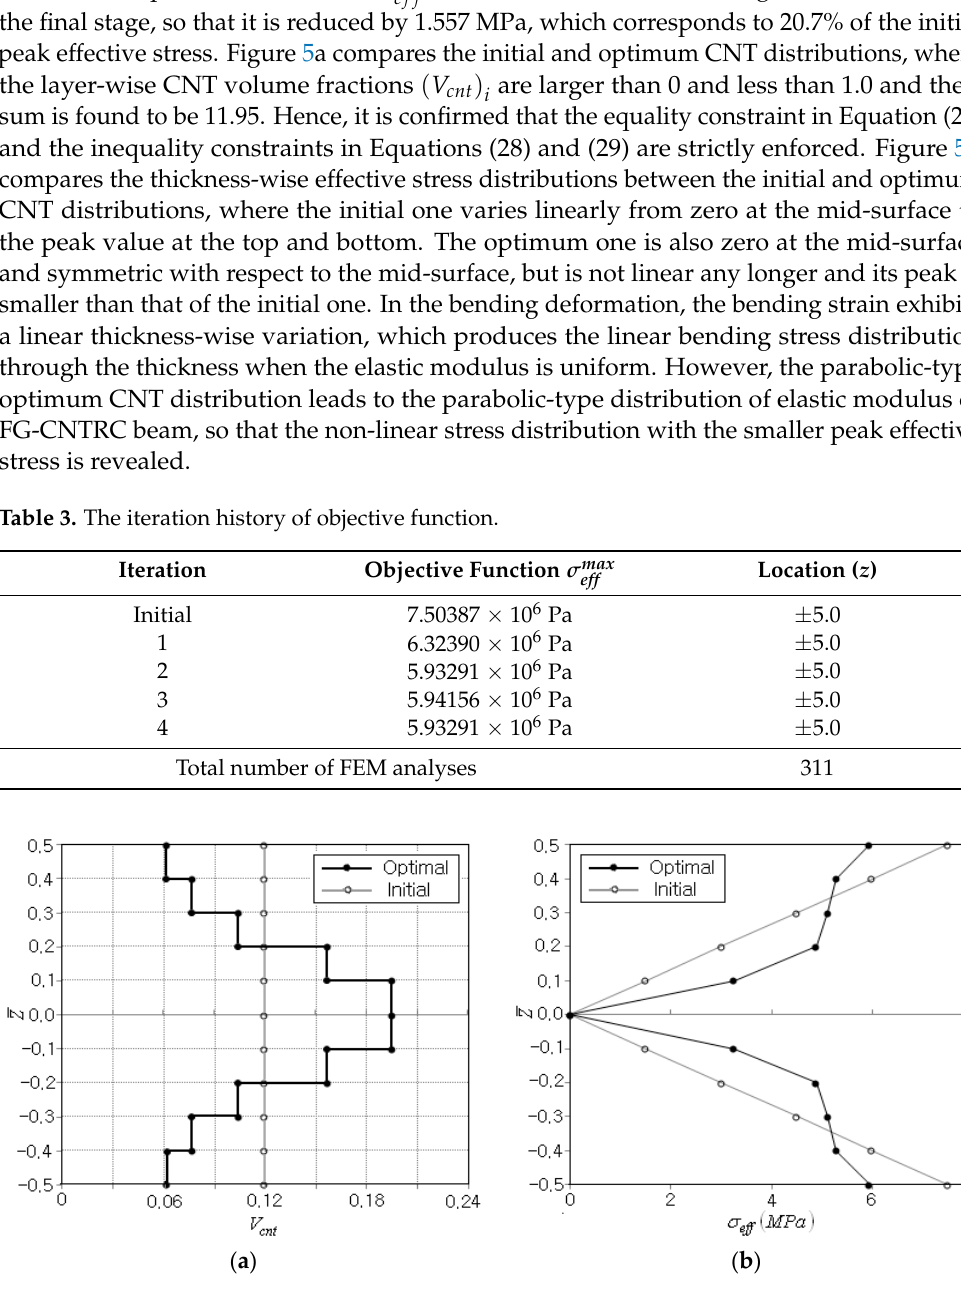
Figure 5. Comparison between the initial and final distributions: ( a ) the CNT volume fraction V ∗ cnt , ( b ) the effective stress σ ef f